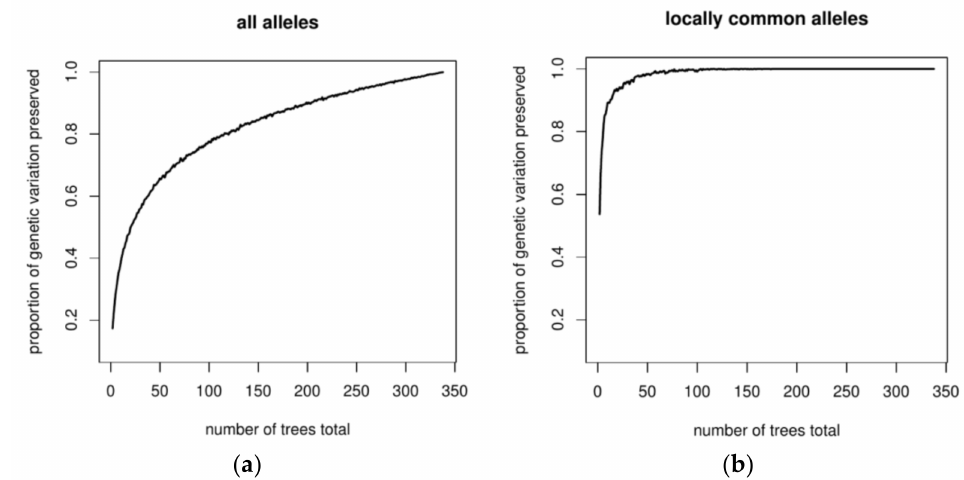
Figure 6. Accumulation analysis which shows an asymptote of low frequency ( a ) and rare ( b ) alleles as more individuals trees are selected across all samples, demonstrating an asymptote is likely reached for locally common but not for all alleles (due to rare